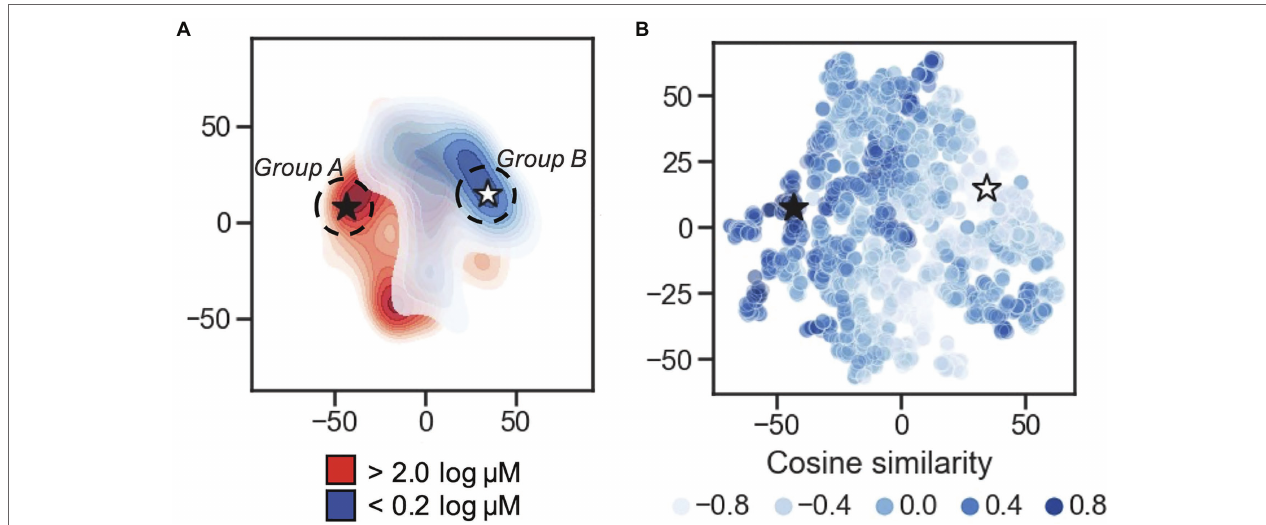
FIGURE 2 | Latent space characterization. Dimensionality reduction for visualization of the 50-dimension latent space. (A) 2D contour plot of t-distributed stochastic neighbor embedding (t-SNE) with two components performed on the encoded peptides. The MIC thresholds for coloring were: <0.2 log μ M is shown in blue, >2 log μ M shown in red, and those with values ≥ 0.2 and ≤ 2 were set to light gray. Regions of higher density are darker. The black star is located at the peptide caseicin B-B1, and a white star is located at the embedding most distant in cosine similarity (encoding for the peptide trialysin peptide P4). Group A and Group B sampling locations are schematically shown at the dashed circle around caseicin B-B1 and trialysin peptide P4, respectively. (B) Scatterplot of t-SNE projection showing encoded peptides colored by cosine similarity calculated using the vector encoding for peptide caseicin B-B1 (black star) as reference. Higher similarity values indicate more similarity between vectors; lower values indicate more